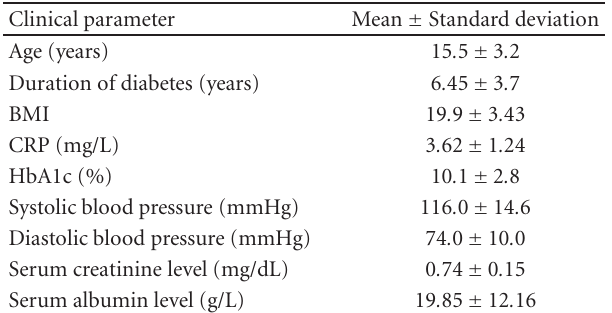
Table 1: Clinical characteristics of patients with type 1 diabetes. Clinical